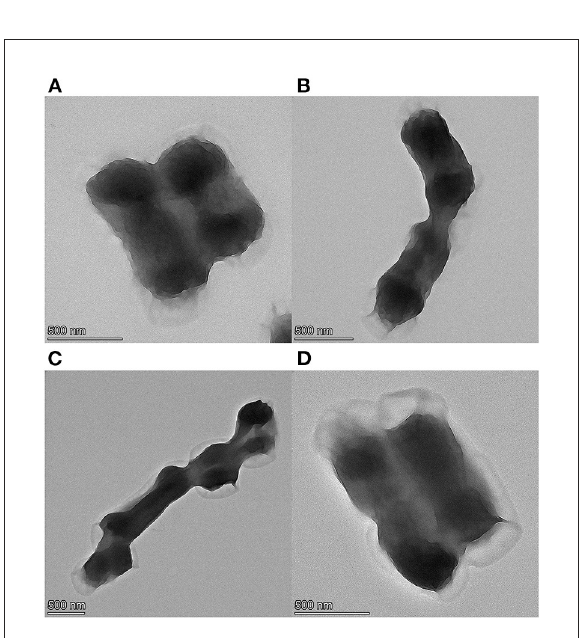
FIGURE2 TEM micrographs of E. coli , (A–D) were treated with cinnamaldehyde at 2MBC for 3, 6, 9, 12h, respectively.